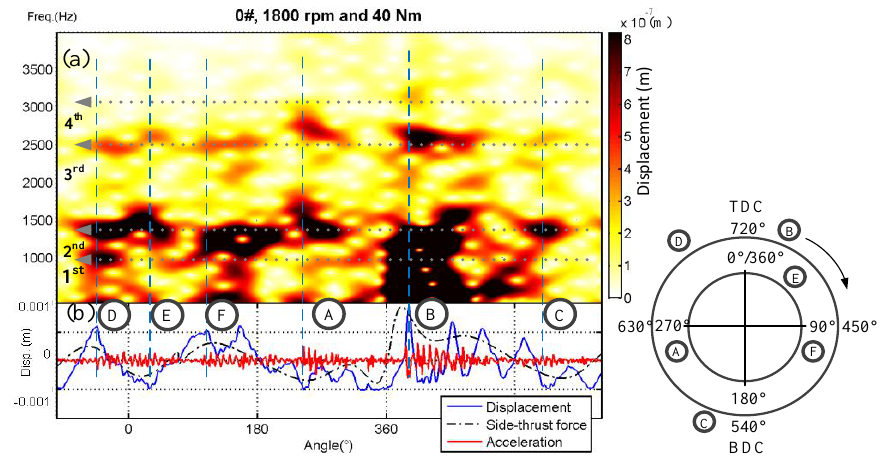
Figure 5. Short-time Fourier transform (STFT) of responses to piston slaps under 40 Nm and 1800 rpm: ( a ) STFT of predicted liner responses; ( b ) piston side-thrust force, the predicted displacement and the predicted acceleration.